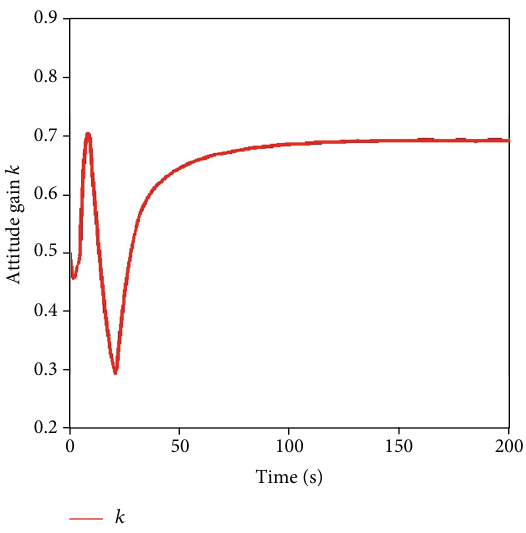
Figure 20: Time histories of attitude quaternions in Case 3 when k ð 0 Þ = 5 .